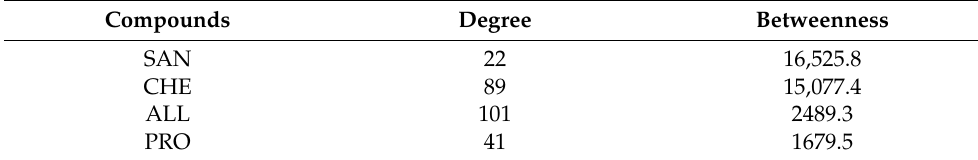
Figure 3. Compound − target interaction network diagram (orange square represents plant, blue diamond represents compound, and purple octagon represents target point, BLH: Boluohui; SAN: Sanguinarine, CHE: Chelerythrine, All: Allocryptopine, PRO: Protopine). Table 2. Network parameters of the